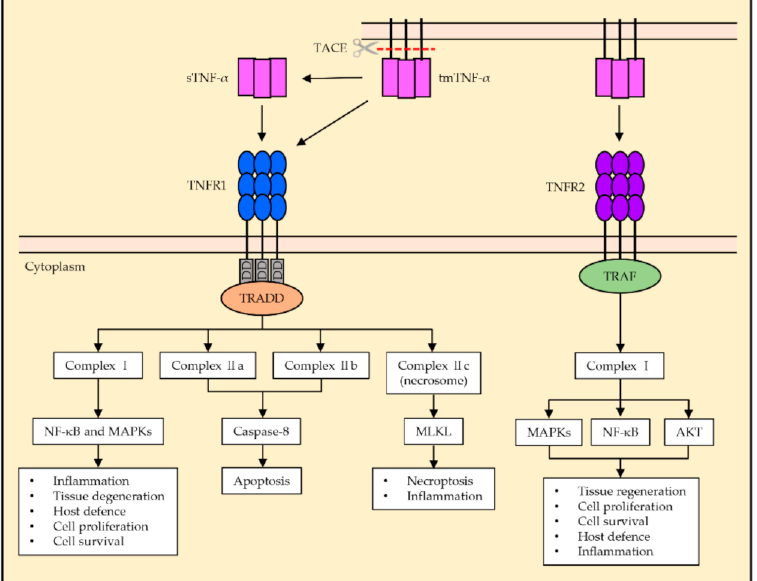
Figure 1. General tumor necrosis factor alpha (TNF- α ) signaling pathway of TNFR1 and TNFR2. The